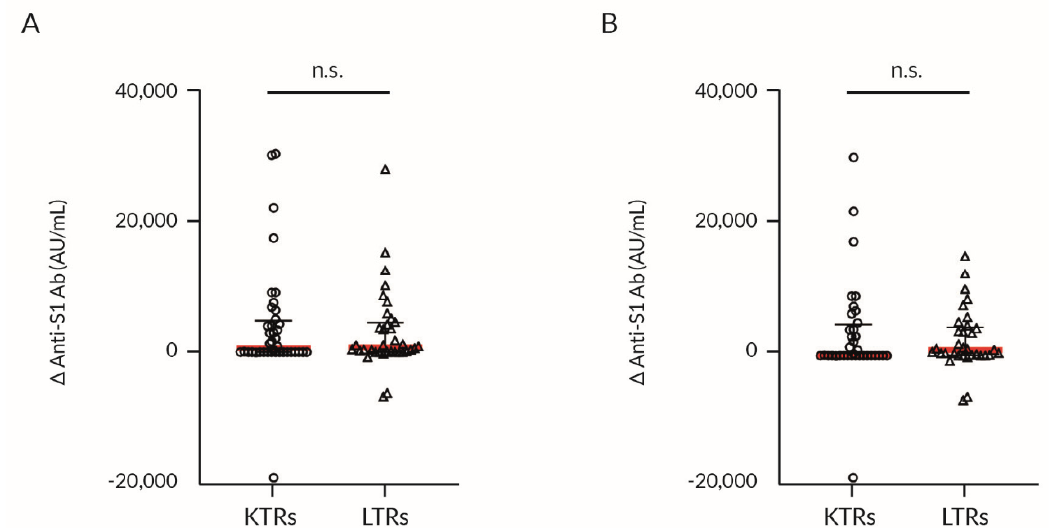
Figure 3. Anti-SARS-CoV-2 spike protein Ab production in response to BNT162b2 vaccination in KTRs and LTRs. Immune response to vaccination depending on the type of transplanted organ. Values are presented as the scatter-dot plot with median (middle line), lower (25%), and upper (75%) quartile (as whiskers); the p -value was calculated with the non-parametric Mann–Whitney U Test. ( A ) All patients including positive history of COVID-19 (confirmed by PCR test), ( B ) Patients without confirmed COVID-19. ∆ anti-S1 Ab—difference in anti-SARS-CoV-2 spike protein antibody concentration between the first and the second dose of the vaccination; BNT162b2 = BioNTech/Pfizer COVID-19 mRNA vaccine; KTRs = kidney transplant recipients; LTRs = liver transplant recipients; n.s. = not significant. Table 2. Comparison of SARS-CoV-2 spike protein Ab concentration (AU/mL) after BNT162b2 vaccination in KTRs and LTRs.